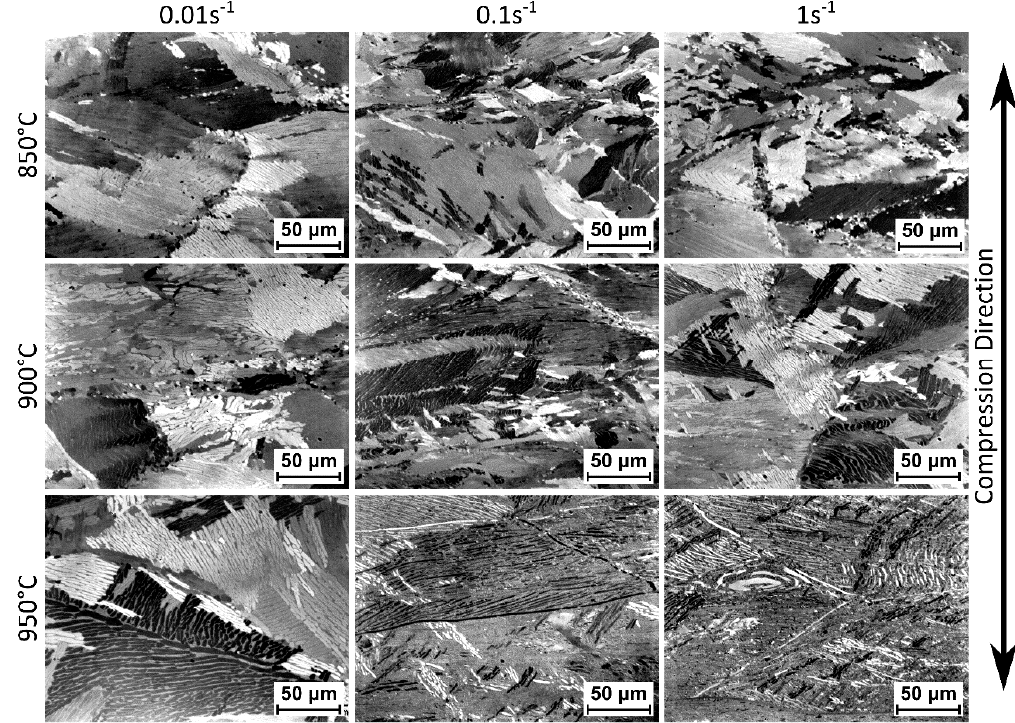
Figure 9. Cross-polarized light micrographs of lower strain dead zone regions in Ti-6Al-4V swarf specimens consolidated via FAST at 1200 °C for 30 min after a subsequent hot compression at 850, 900, or 950 °C, and a strain rate of 0.01, or 0.1, or 1 s − 1 (as labelled).